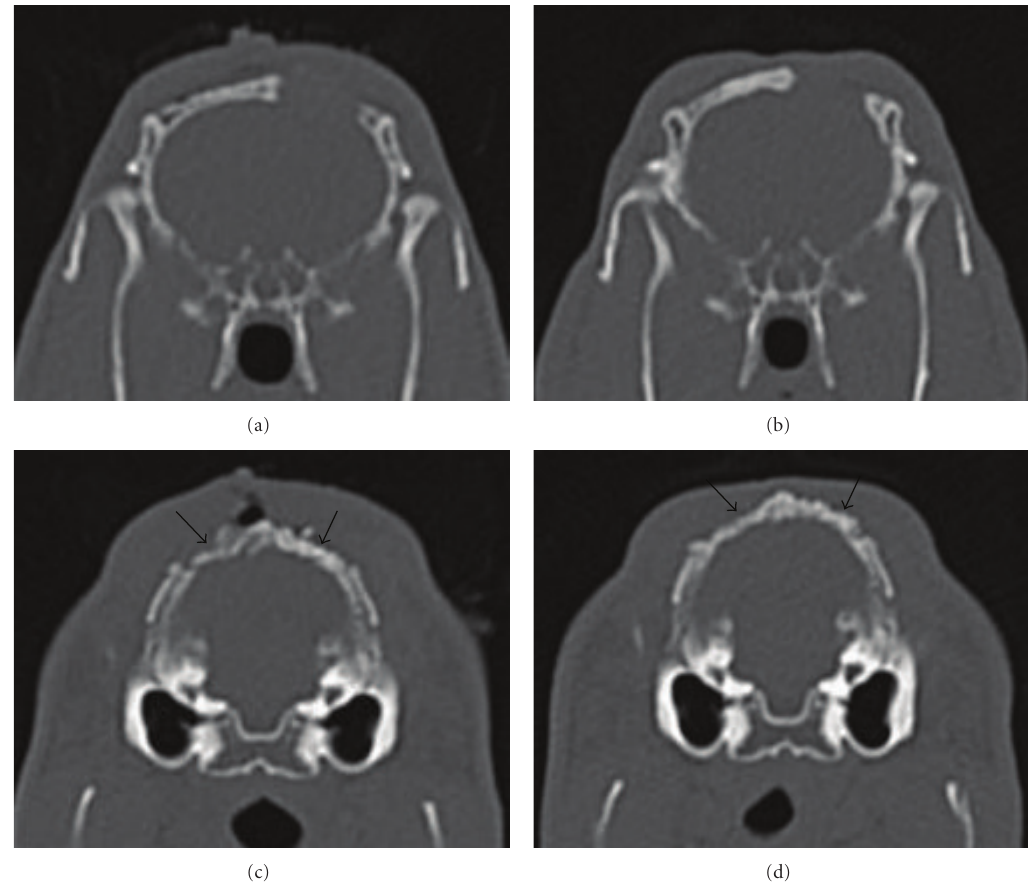
Figure 3: Post-op CT scan of (a) unfilled area immediately after surgery; (b) unfilled area 6 weeks postoperatively; (c) dentin-filled defect (right arrow) and the autogenous bone-filled defect (left arrow) immediately after surgery; (d) dentin-filled defect (right arrow) and the autogenous bone-filled defect (left arrow) 6 weeks